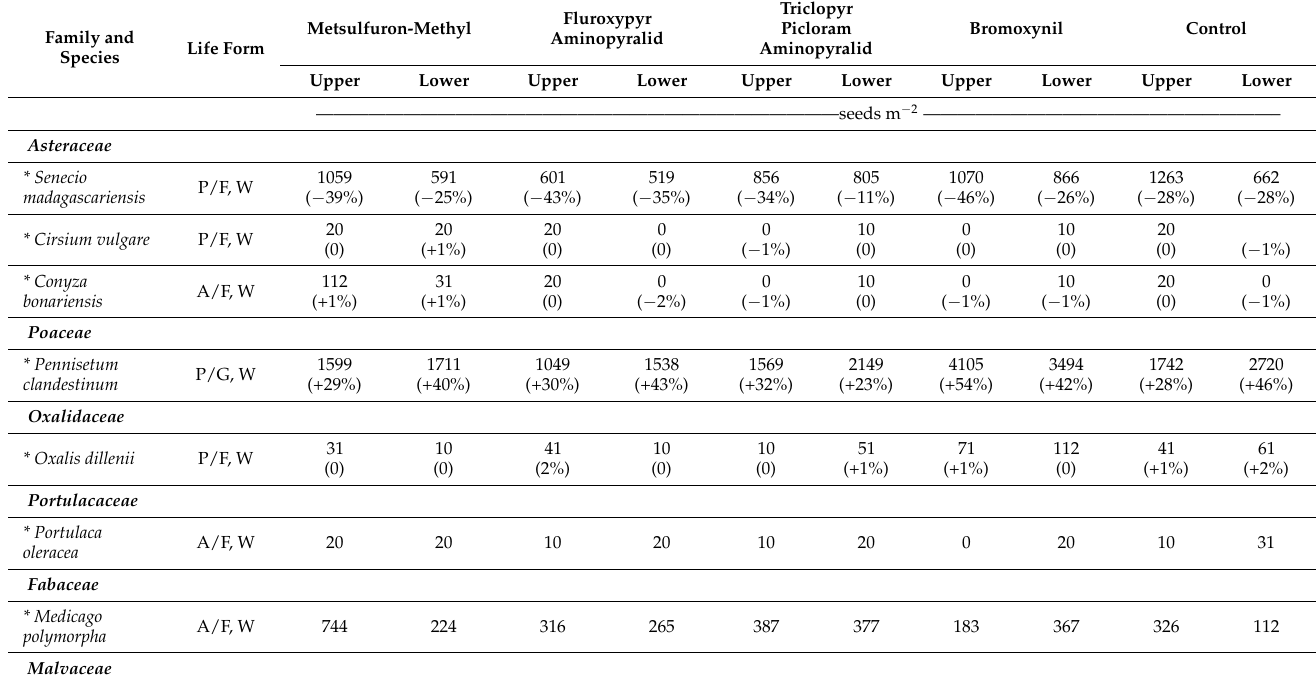
Table 3. Species density and change in seed density of germinable soil seed bank species found in a kikuyu pasture at Beechmont, Queensland, after spraying twice with herbicides metsulfuron-methyl, at two soil depths: upper (0 to 2 cm deep) and lower (2 to 10 cm